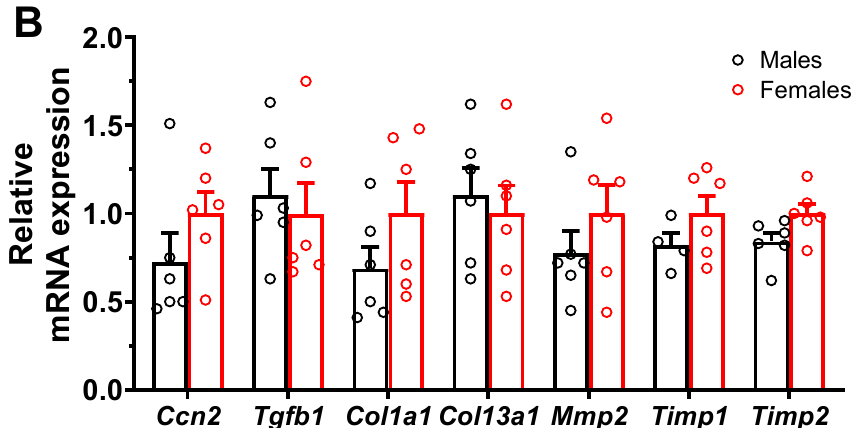
Figure 4. Similar level of interstitial fibrosis in male and female atrial myocytes. ( A ). Typical collagen picrosirius red staining (stained red) of left atria of male and female mice, at a 4 × and 20 × magnification zoom. Scale bars represent 100 and 500 µ m, at 4 × and 20 × , respectively. The scatter plots reveal no differences in atrial fibrous content between males and females (M: 4.9 ± 1.2 %, n = 4; F: 5.3 ± 0.7 %, n = 4; p = 0.79). ( B ). qPCR analysis shows that the mRNA expression level of genes involved in fibrosis pathways was similar between male and female atria (n = 4–6/group).